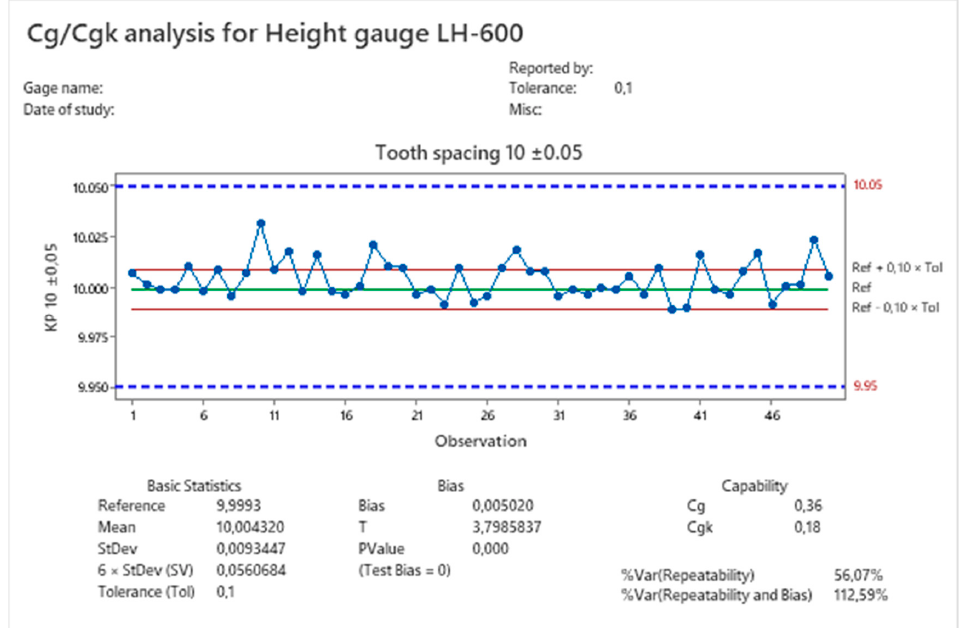
Figure 17. Interpretation of the 20 percent tolerance for repeatability of measuring equipment (own study).